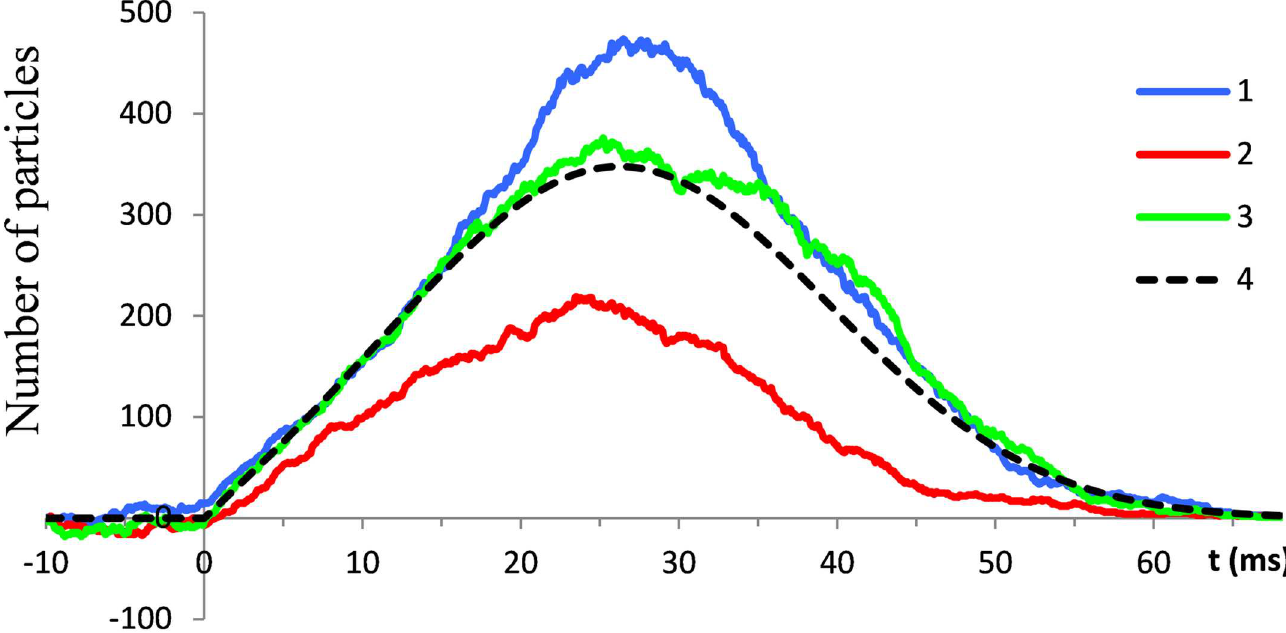
Fig 9. Using the same conditions as the simulations in Fig 8, illustrates the sensitive dependence of X N (t) realizations in different trials (coloured lines) on initial conditions. The dotted line is a theoretical solution.